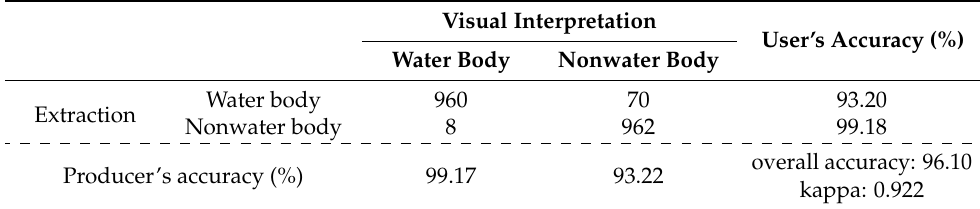
Table 2. The confusion matrix for the accuracy assessment of the extracted water bodies.